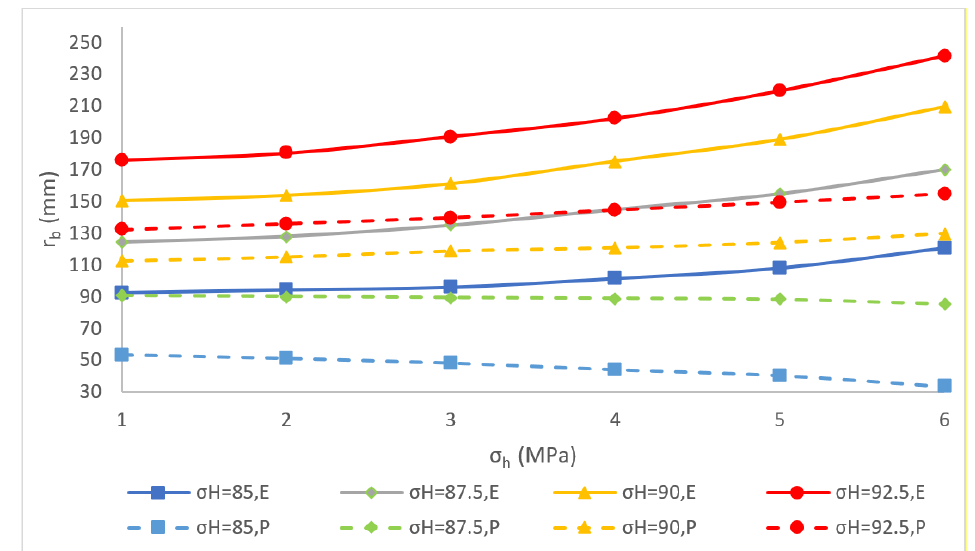
Figure 12. Comparison of breakout depth between thermoporoelastic and thermoporoelastoplastic model.